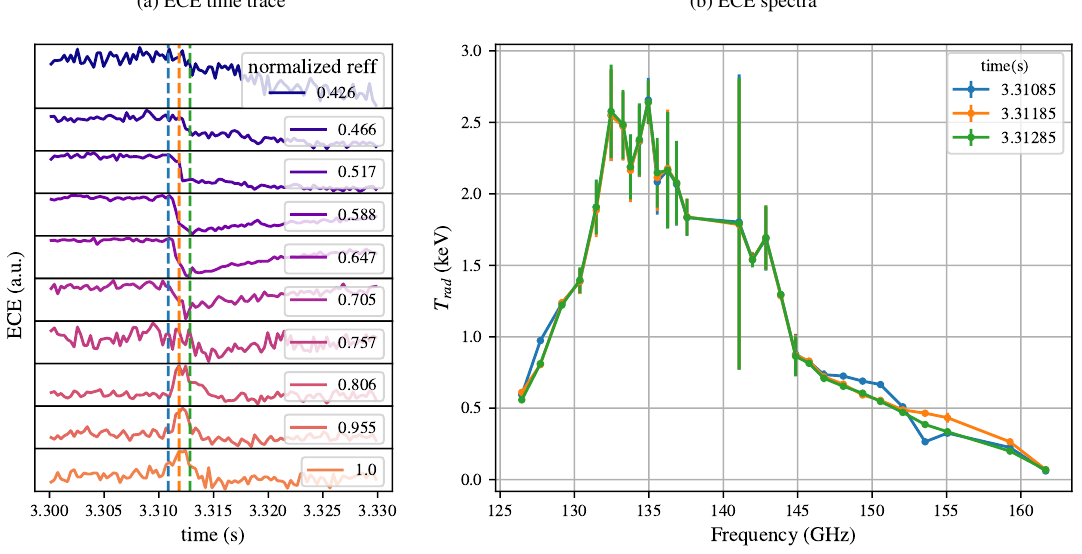
Figure 3: (a) A single crash in T e shown using ECE data for #20180927.026. Three time points from this crash have been chosen to see the ECE spectra during the crash. The channel around which the neighbouring channels are out of phase is the location of the crash and correspond to inversion radius ( r ef f = 0 . 757) of the crash in the plasma. (b) The corresponding ECE spectra before (blue curve) and during (orange and green curve) the crash are shown. It can be clearly observed that the location of crash coincides with the location of the